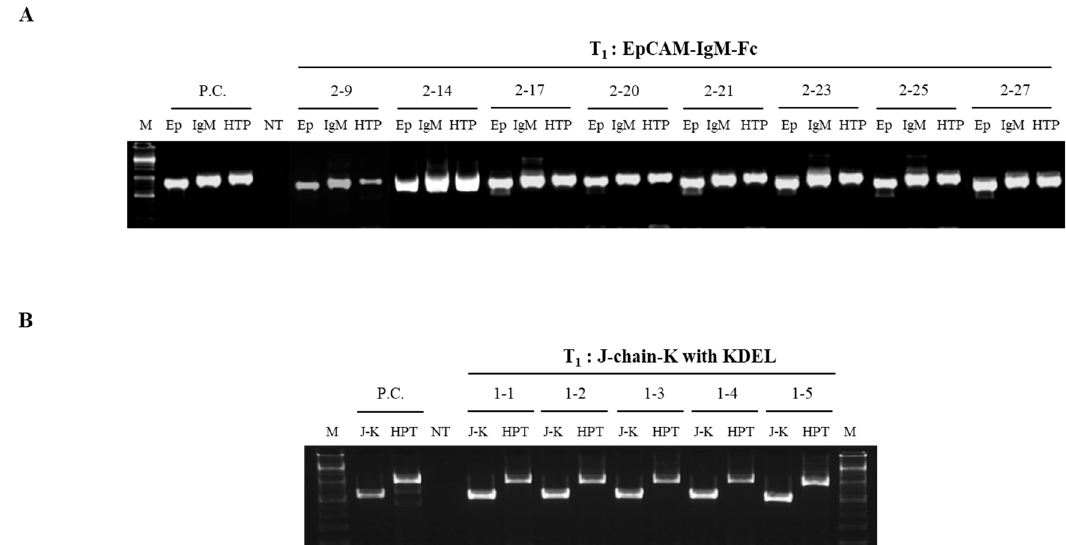
Figure 5. A polymerase chain reaction (PCR) analysis to confirm the transgenes encoding EpCAM–IgM Fc and J-chain K in the T 1 transgenic lines. ( A ) T 1 transgenic lines (#2–9, 2–14, 2–17, 2–20, 2–21, 2–